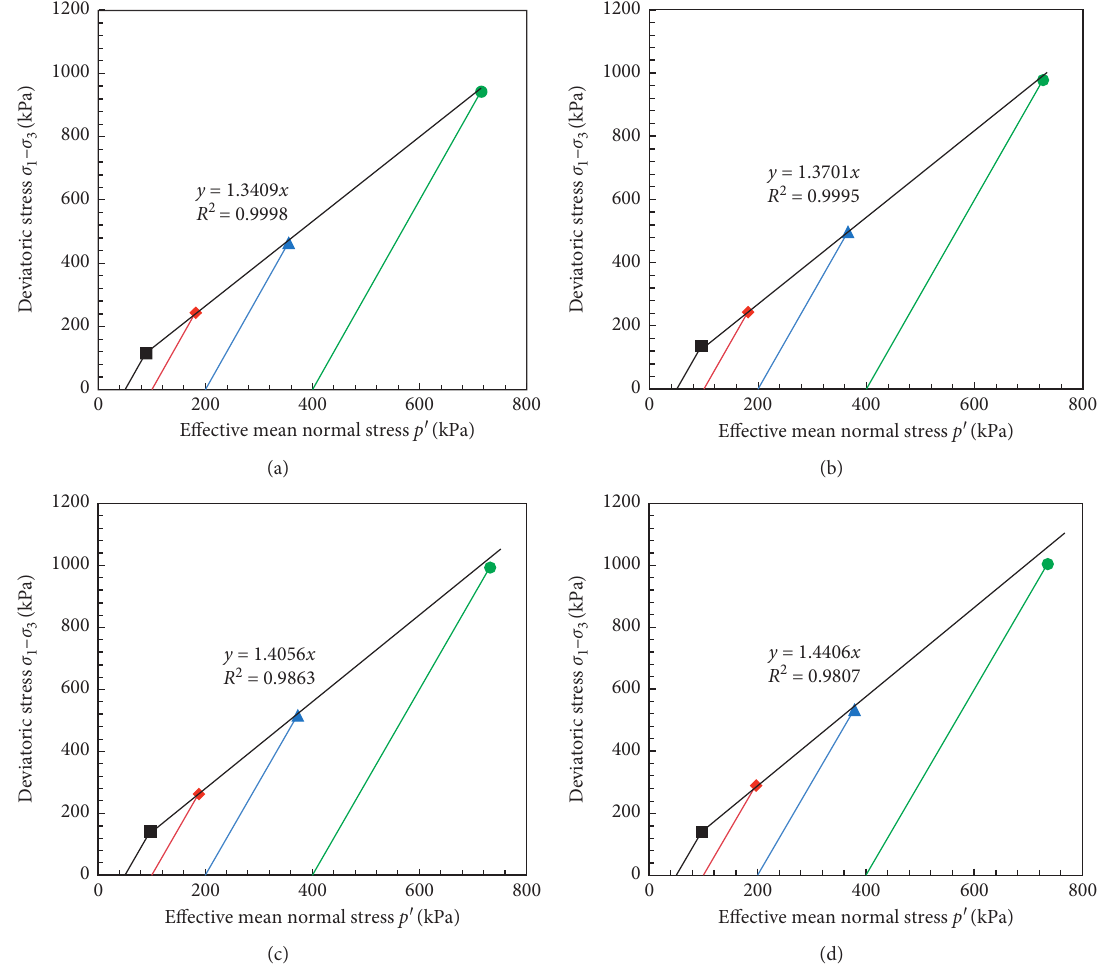
Figure 11: Critical state curves M of gravelly sand for four different initial relative densities. (a) Gravelly sand D D r � 0.35. (c) Gravelly sand D r � 0.55. (d) Gravelly sand D r �